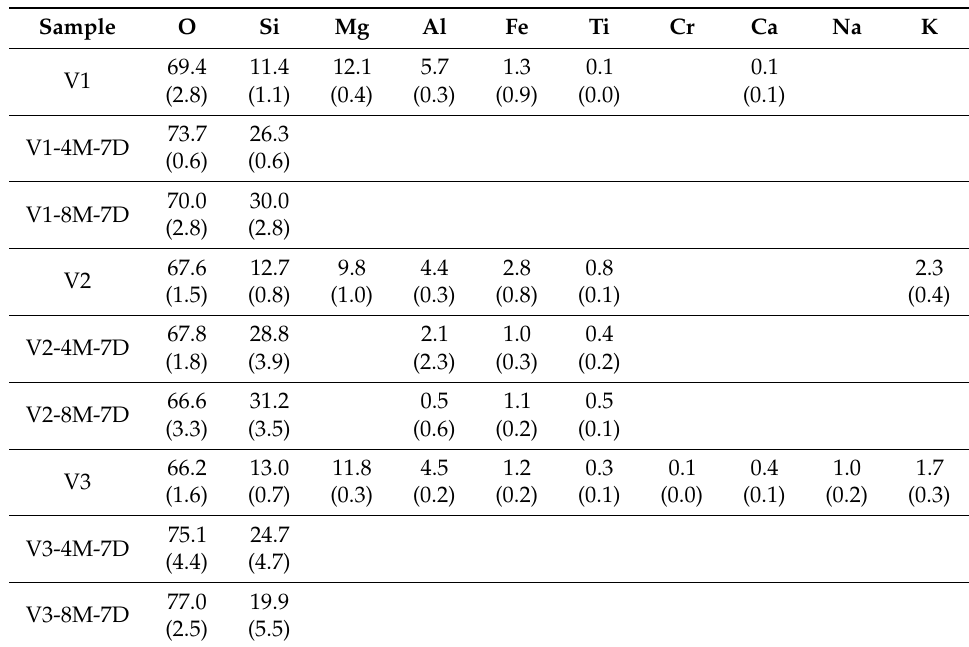
Table 3. Elemental analyses (at %) for V1, V2, and V3 pre- and post-treatment with 4 and 8 M nitric acid for 7